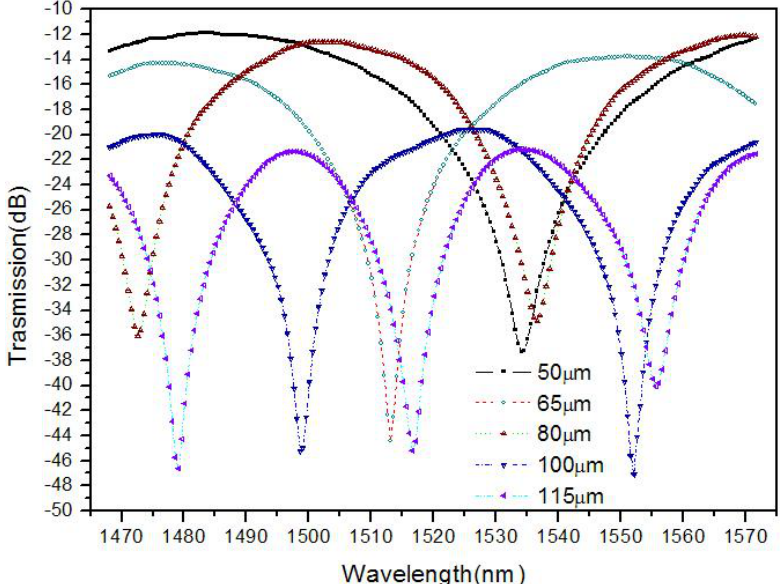
Figure 4. Transmission spectra of the structures at different